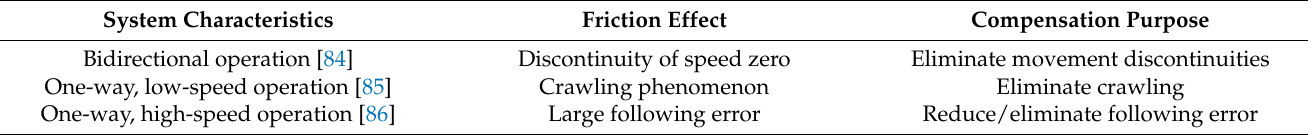
Table 4. Purpose of friction compensation.